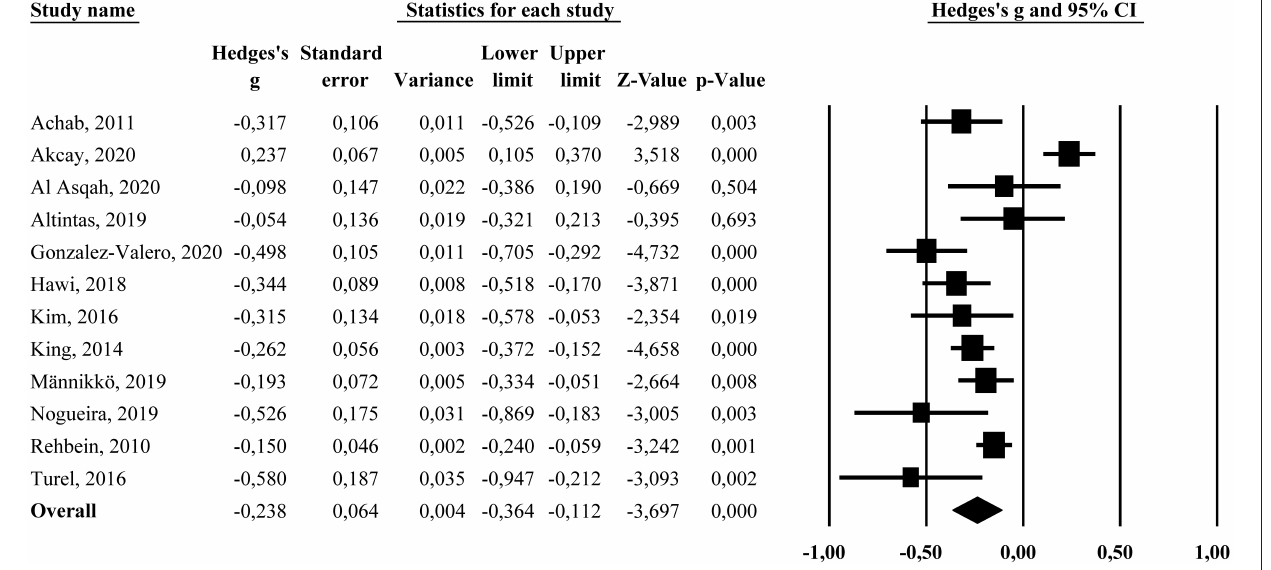
FIGURE 2 | Forest plot showing the association (Hedges’s g ) between problematic gaming and sleep